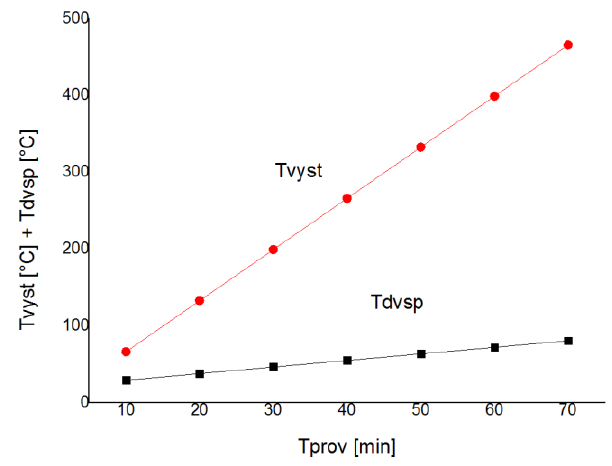
Figure 3. Dependence of water temperature on the output Tvyst ( ◦ C) and temperature of the handle of bottom doors Tdvsp ( ◦ C) on the working time Tprov (min), for the boilers with power output up to 100 kW.